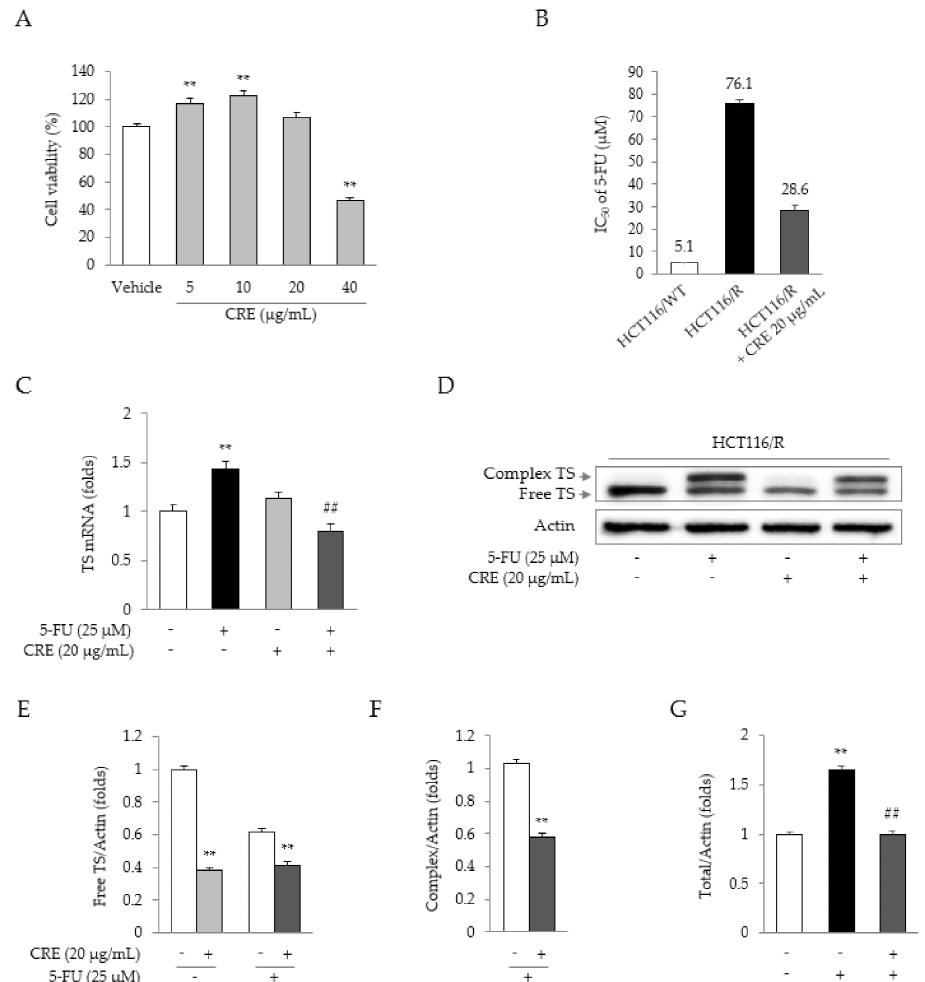
Figure 3. CRE reverses drug resistance by downregulating TS expression. HCT116/R cells were treated with various concentrations of CRE ( A ). Anti-proliferative IC 50 value of co-treatment with CRE or 5-FU in HCT116/WT and HCT116/R cells ( B ). TS gene expression was measured in HCT116/R cells treated with CRE or 5-FU ( C ). The protein level of TS was measured in HCT116/R cells treated with CRE or 5-FU ( D ), and the intensities of free ( E ), complexed ( F ), and total TS ( G ) were quantified. Data are expressed as the mean ± SD ( n = 3) values. ** p < 0.01, as compared to vehicle-treated cells. ## p < 0.01 compared to 5-FU-treated